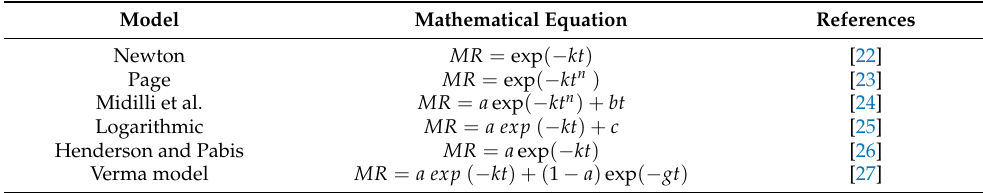
Table 1. Mathematical models given by several authors for drying